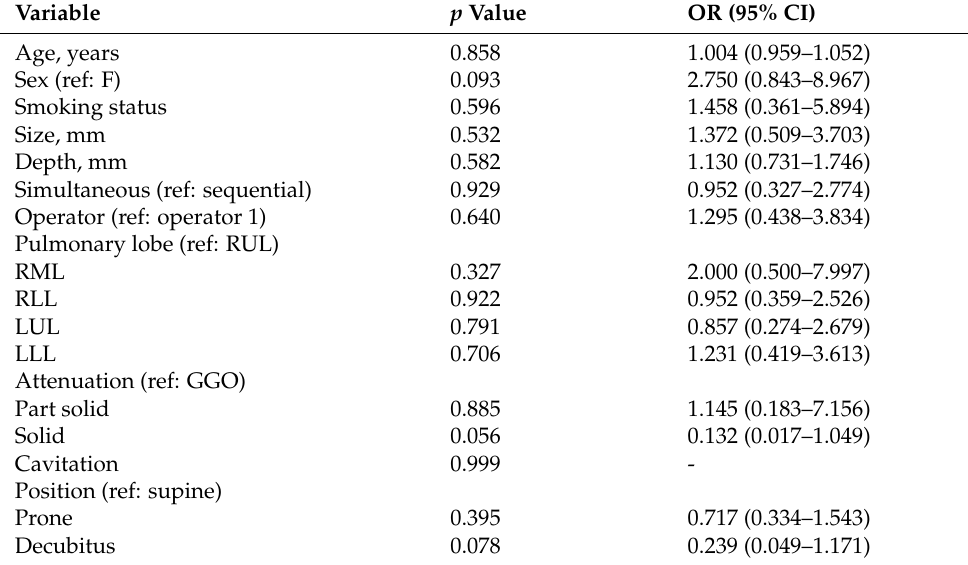
Table 3. Risk factors for procedure-related pneumothorax.